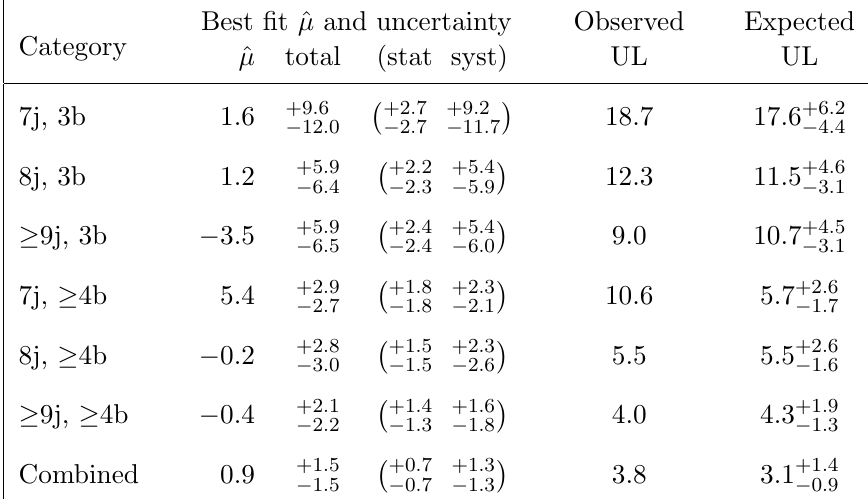
The signal is displayed in (cid:12)gure 8 in terms of the distribution in log S = B is the ratio of the signal to background yields in each bin of the six MEM discriminant histograms, obtained from a combined (cid:12)t constrained to the SM cross section of (cid:22) = 1. Good agreement is found between the data and the sum of the SM signal and background over the whole range of this